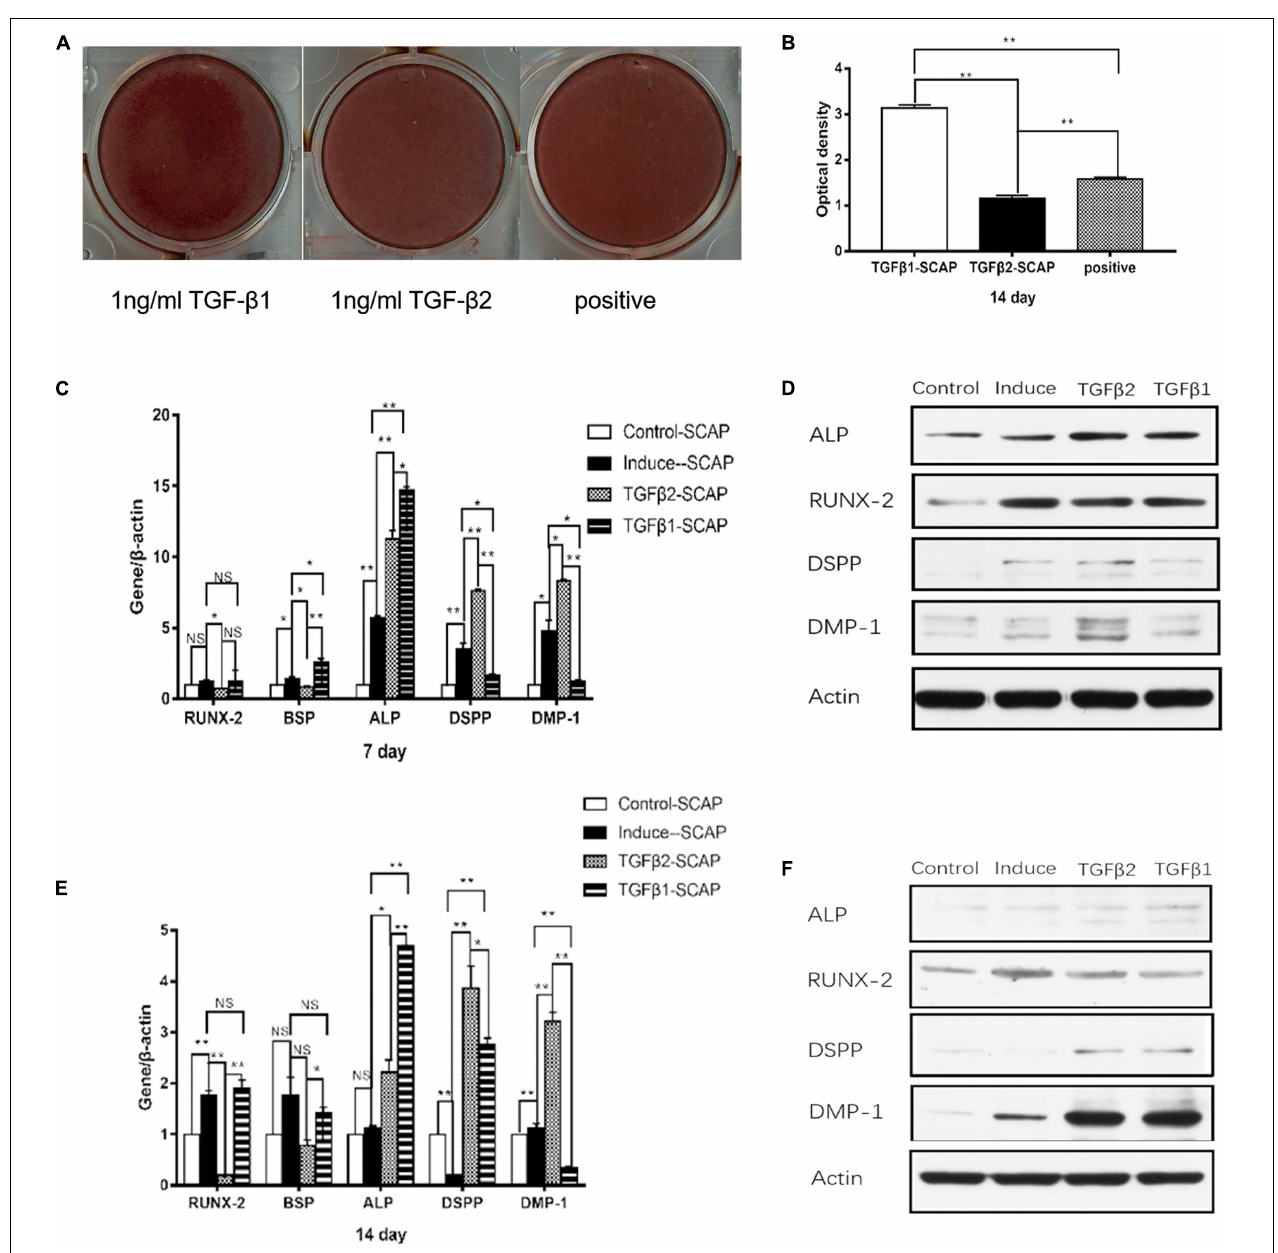
FIGURE 4 | The effects of recombinant human TGF β 1 (rhTGF β 1) and rhTGF β 2 on the osteo/odontogenic differentiation of SCAPs. (A) After 2 weeks of culturing in different media, calcium mineral deposition was detected by alizarin red staining. (B) Quantitative measurement of alizarin red staining. Mineralization was significantly higher in the TGF β 1 group than in the OM group and significantly lower in the TGF β 2 group than in the OM group. All data are presented as the mean ± SD; ** p < 0.01; each experiment was repeated three times. (C,E) Real-time RT-PCR showing mRNA level of runt-related transcription factor 2 (RUNX2), ALP, bone sialoprotein (BSP), dentin sialophosphoprotein (DSPP), and dentin matrix protein 1 (DMP1) of SCAPs after culturing in different medium at 7 days (C) and 14 days (E) . All data are presented as the mean ± SD (* p < 0.05; ** p < 0.01; NS, no significance). Each experiment was repeated three times. (D,F) Western blotting analysis of expression of RUNX2, ALP, DSPP, and DMP1 of SCAPs after culturing in different medium at 7 days (D) and 14 days (F) .